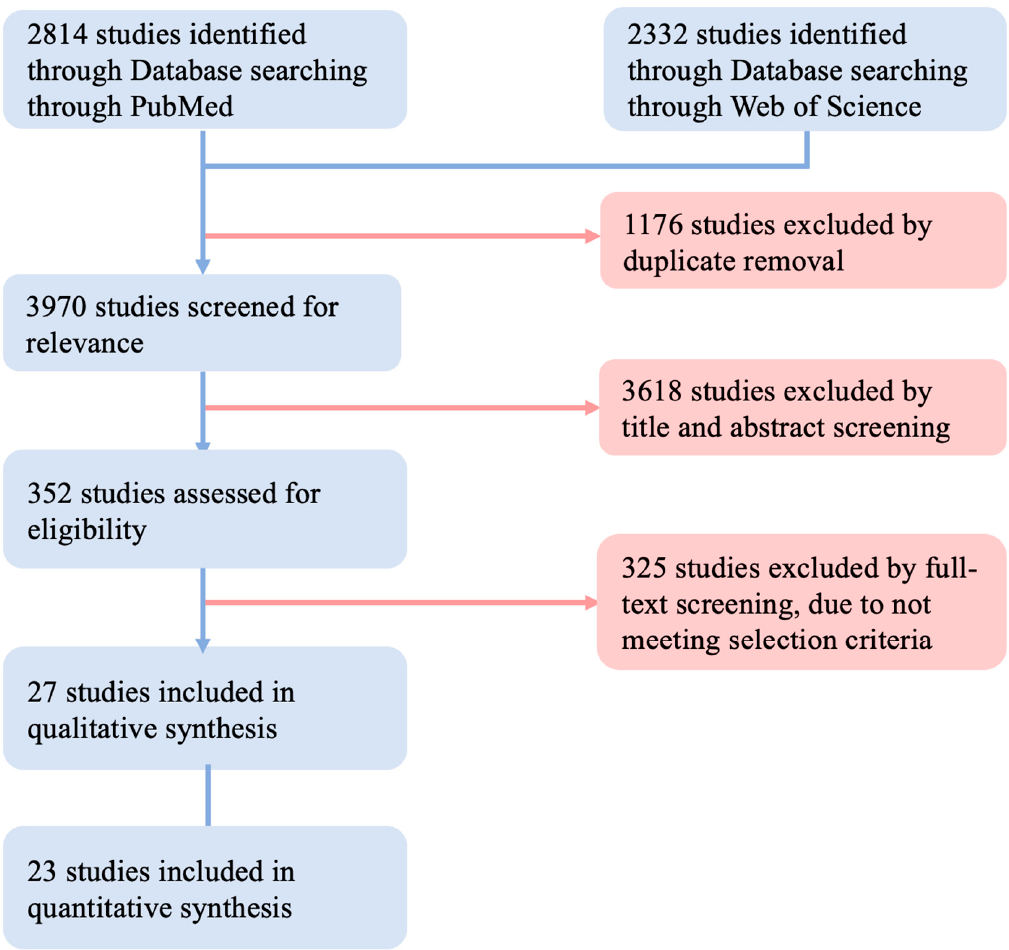
Figure 1. The related studies were searched and included according to the PRISMA guidelines.